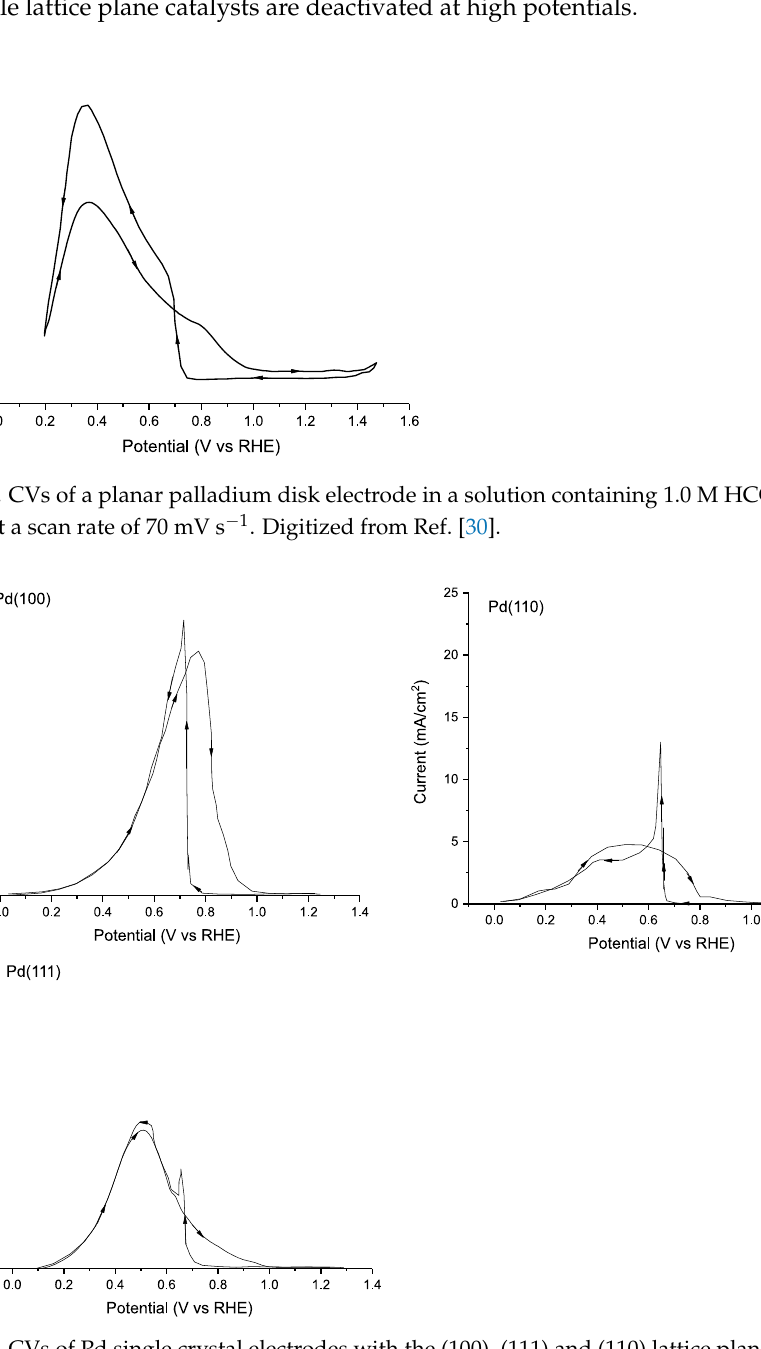
Figure 7. CVs of Pd single crystal electrodes with the (100), (111) and (110) lattice planes exposed of solutions containing 0.1 M HCOOH + 0.1 M HClO 4 (pH ≈ 1.0) 20 mV s − 1 . Digitized from Ref. [111]. solutions containing 0.1 M HCOOH + 0.1 M HClO ≈ 1.0) 20 mV s − 1 . Digitized from Ref. 4 (pH